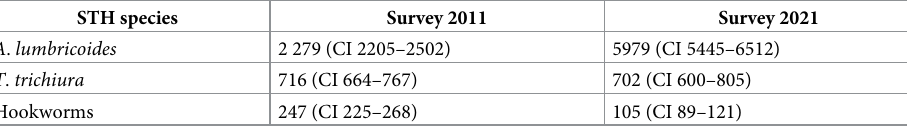
Table 4. Mean intensity of infection in eggs per gram by